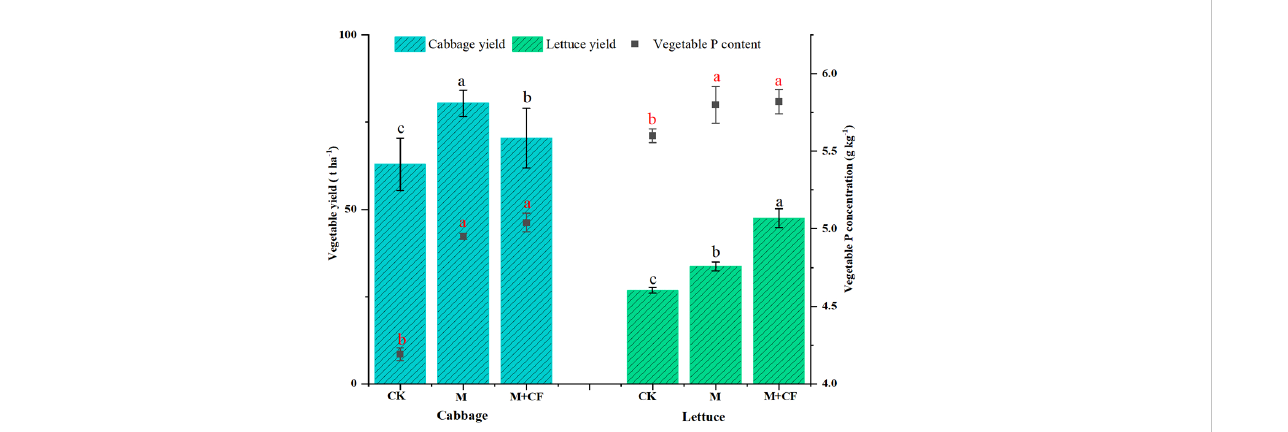
FIGURE 6 Vegetable yield and vegetable P concentration. Bars over the marker show standard error (n=3). Black different letters above the columns indicate signi fi cant differences in vegetable yield at P <0.05, and red different letters above the squares indicate signi fi cant differences in vegetable P concentration at P <0.05.